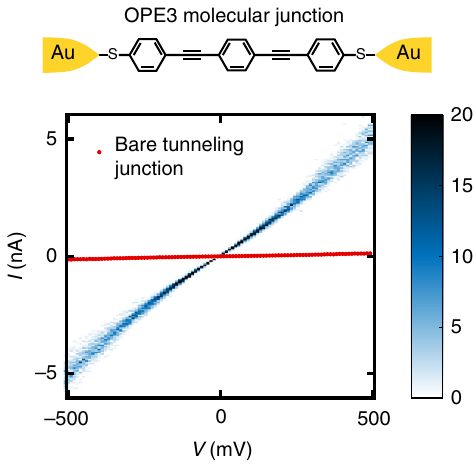
Fig. 5 Demonstration of the formation of a molecular junction using a crack-de fi ned break junction. The schematic is an idealized depiction of a dithiol-terminated oligo(phenylene ethynylene) molecule (OPE3) molecule deposited in a crack-de fi ned break junction. The I – V characteristics of tunneling gaps were measured before and after the process of OPE3 deposition and the successful formation of a molecular junction is indicated by a large increase in conductance of a tunneling gap, typically by an order of magnitude or more. The I – V histogram of the OPE3 junction plotted here consists of 64 successive I – V traces, and the conductance increased